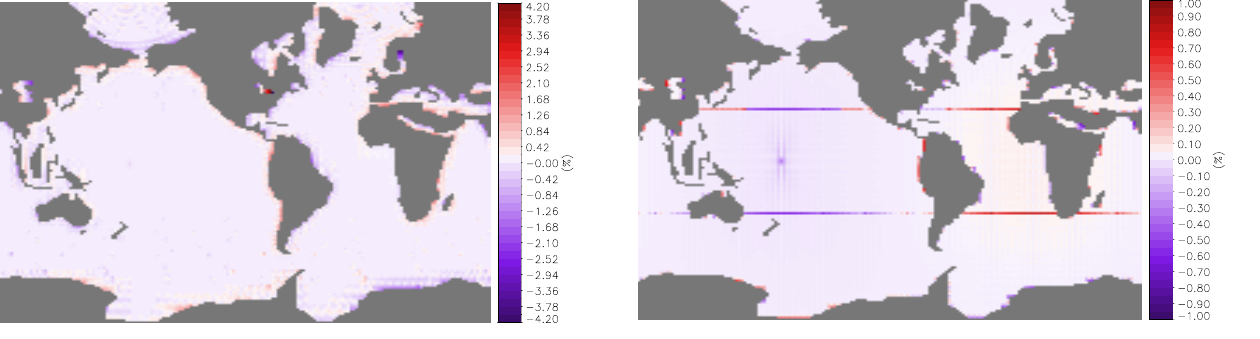
Fig. 6. Relative error obtained (in %) with the bicubic regridding from the Gauss-reduced grid to the ORCA2 grid.